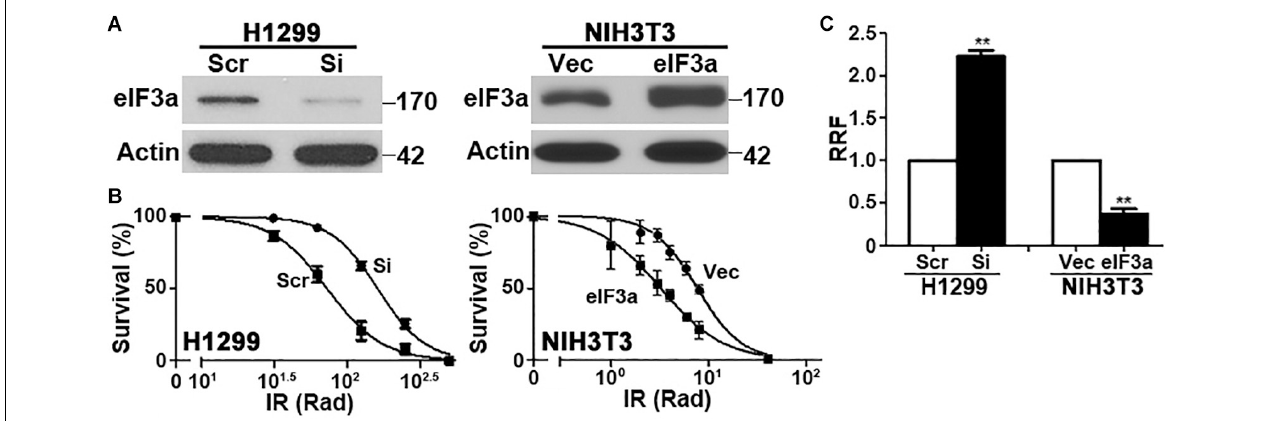
FIGURE 1 | Effect of eukaryotic initiation factor (eIF)3a expression on the cellular response to ionizing radiation (IR). Western blot analyses (A) and colony formation assay following IR treatment (B) of H1299 cells with transient eIF3a knockdown and NIH3T3 cells with stable eIF3a overexpression compared with their respective control cells. Actin was used as a loading control. Panel (C) shows a summary of eIF3a effects on cellular sensitivity to IR treatments. Relative resistance factor (RRF) was derived by dividing the IC 50 of the test cells by that of their control cells ( n = 3, ** P < 0.01).